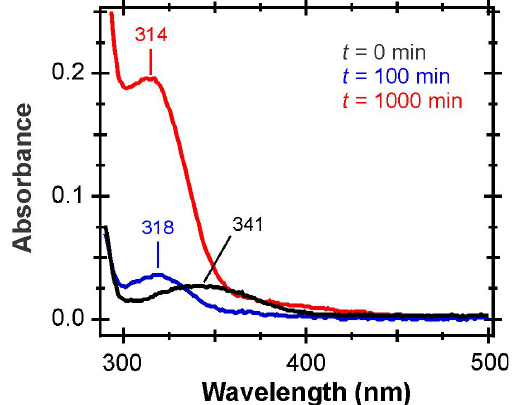
Fig. 8. Diffuse reflectance UV–visible absorbance spectra of NaCl- adsorbed eugenol exposed to 240ppb O 3 at t = 0, 100, and 1000min.